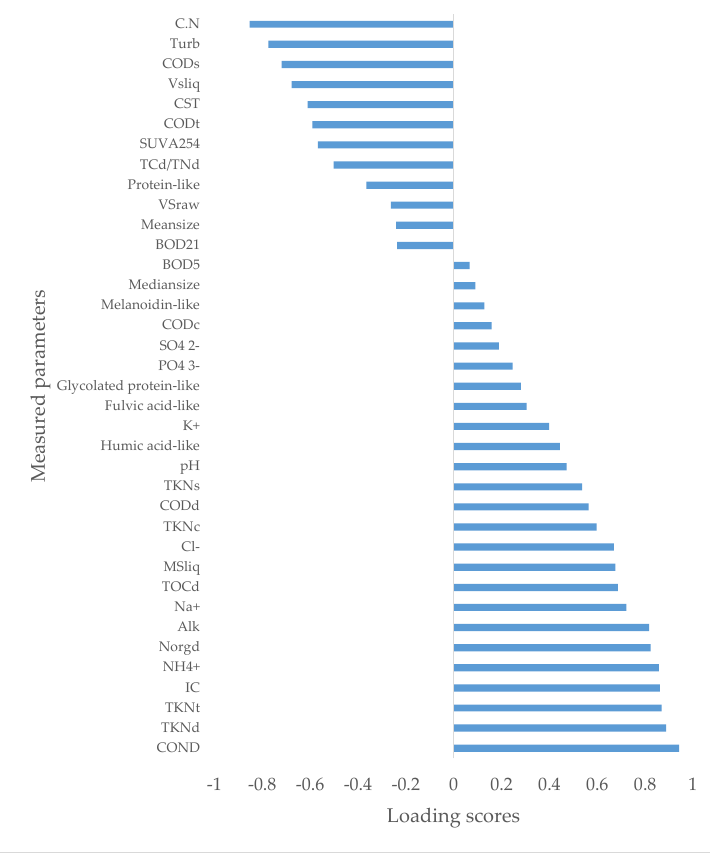
Figure 3. Loading scores of measured parameters of Dimension 1.